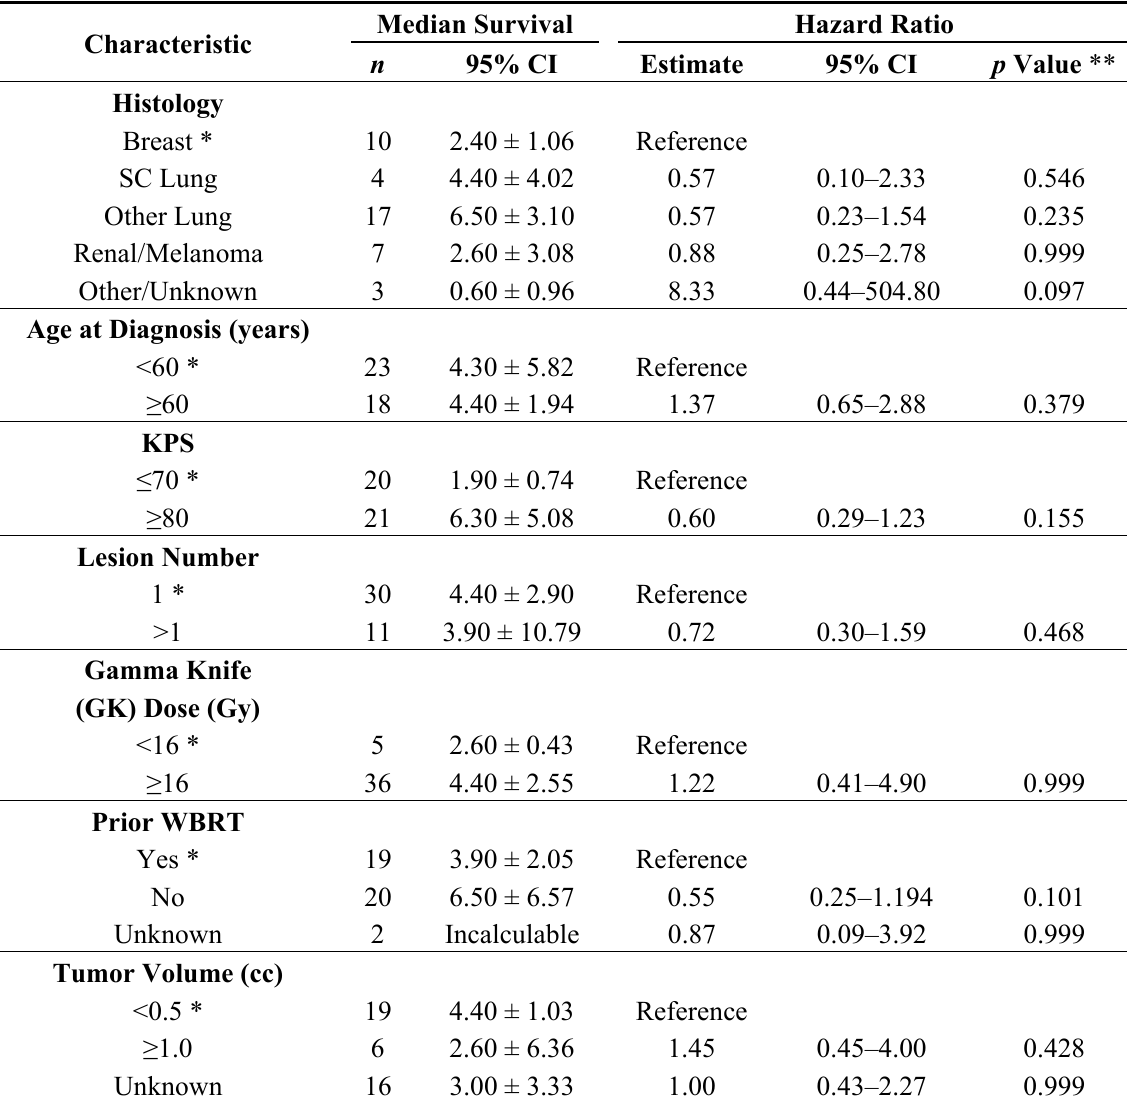
Table 2. Univariate analysis of median